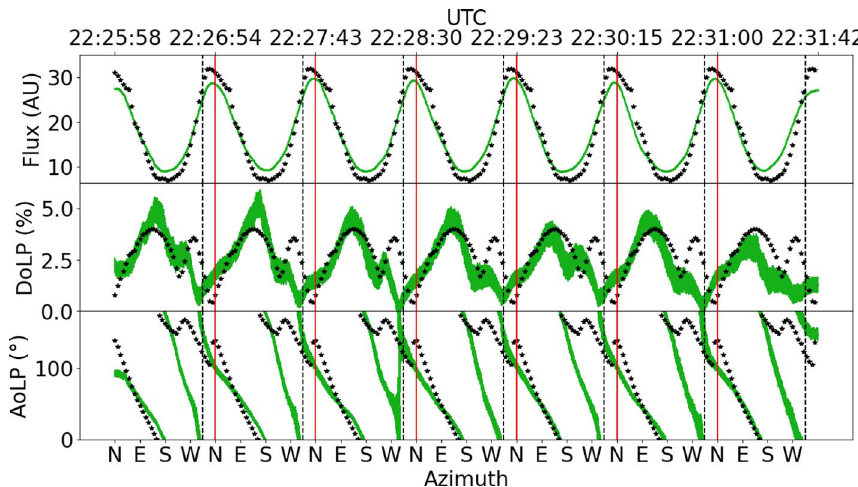
Fig. 8. 7 almucantar observations at 557.7 ± 5 nm (February 27, 2020): observations (in green) and predictions for the model that best fi ts the data (Black stars H ). The model is a linear combination of ground and sky (including albedo) for a 5% polarised sky emission in a direction de fi ned by an azimuth of 50 (cid:3) and (cid:3) 20 (cid:3) elevation (see text for details). The dashed vertical black line indicates the direction of Skibotn. The picture of the sky at 557.7 nm is shown in Appendix A.